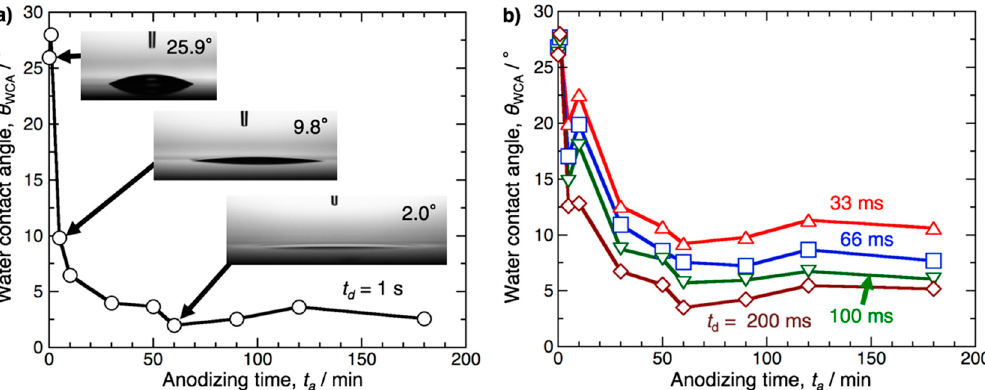
Figure 1. ( a ) Change in the water contact angle measured on the anodized aluminum surface, θ WCA , with the anodizing time t a . The electropolished specimens were anodized in pyrophosphoric acid at 283 K and 80 V for 1 − 180 min, and the contact angles were measured at t d = 1 s after a 0.5 µL water droplet was placed on the surface. ( b ) The θ WCA − t a curves obtained at t d = 200, 100, 66, and 33 ms.